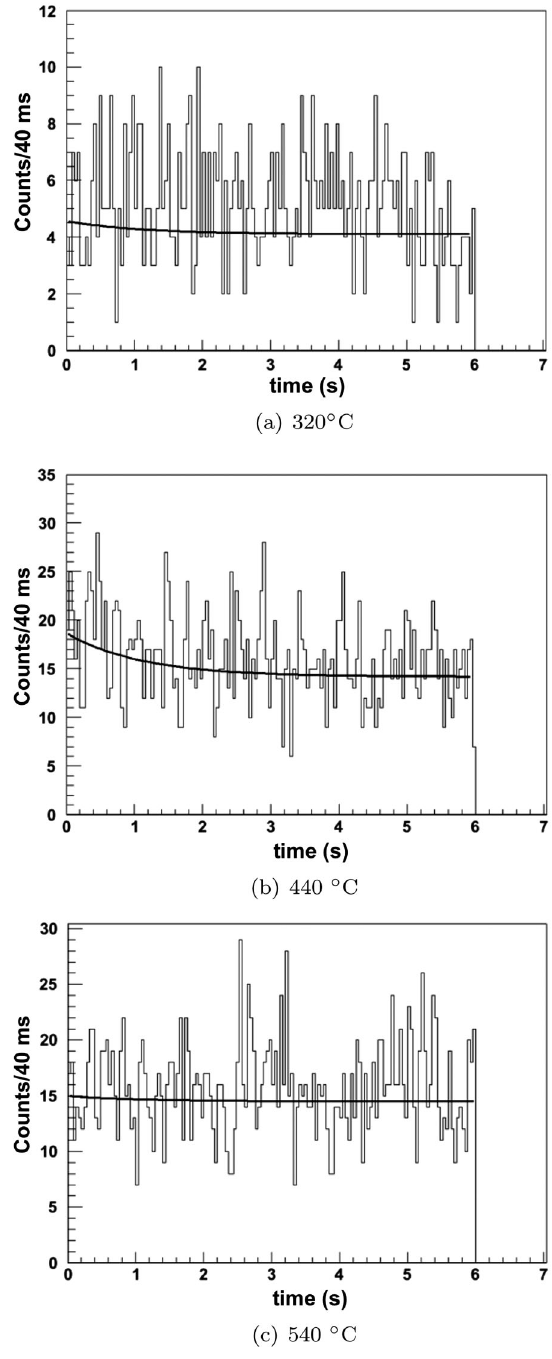
¼ FIG. 16. Decay of 8B (setup with the collection device and 1 = 2 AlF 3 ) at 320 °C (a), 440 °C (b), and 540 °C